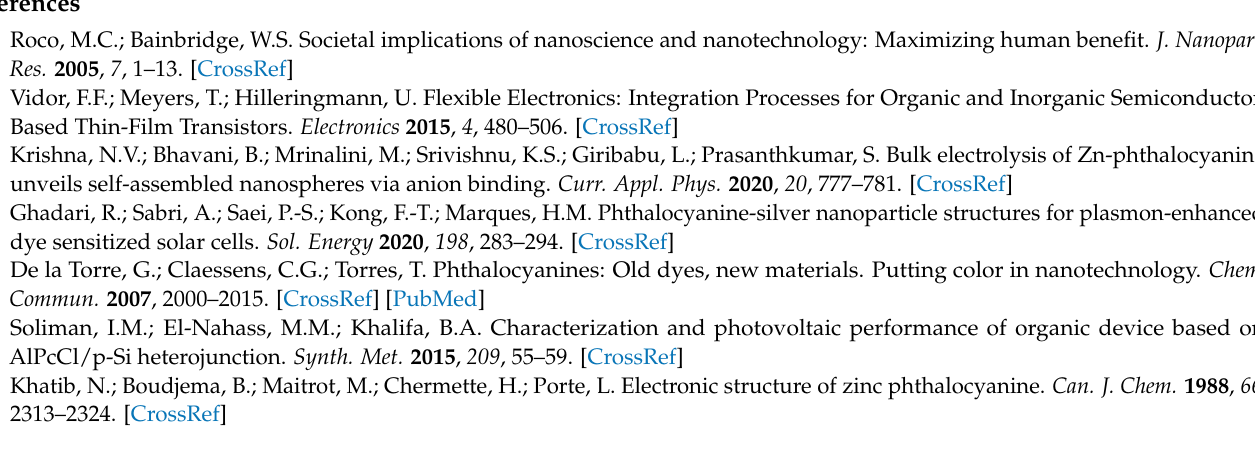
Figure S2: SEM micrograph for I-CuPc; Figure S3: SEM micrograph for I-CoPc; Figure S4: SEM micrograph for